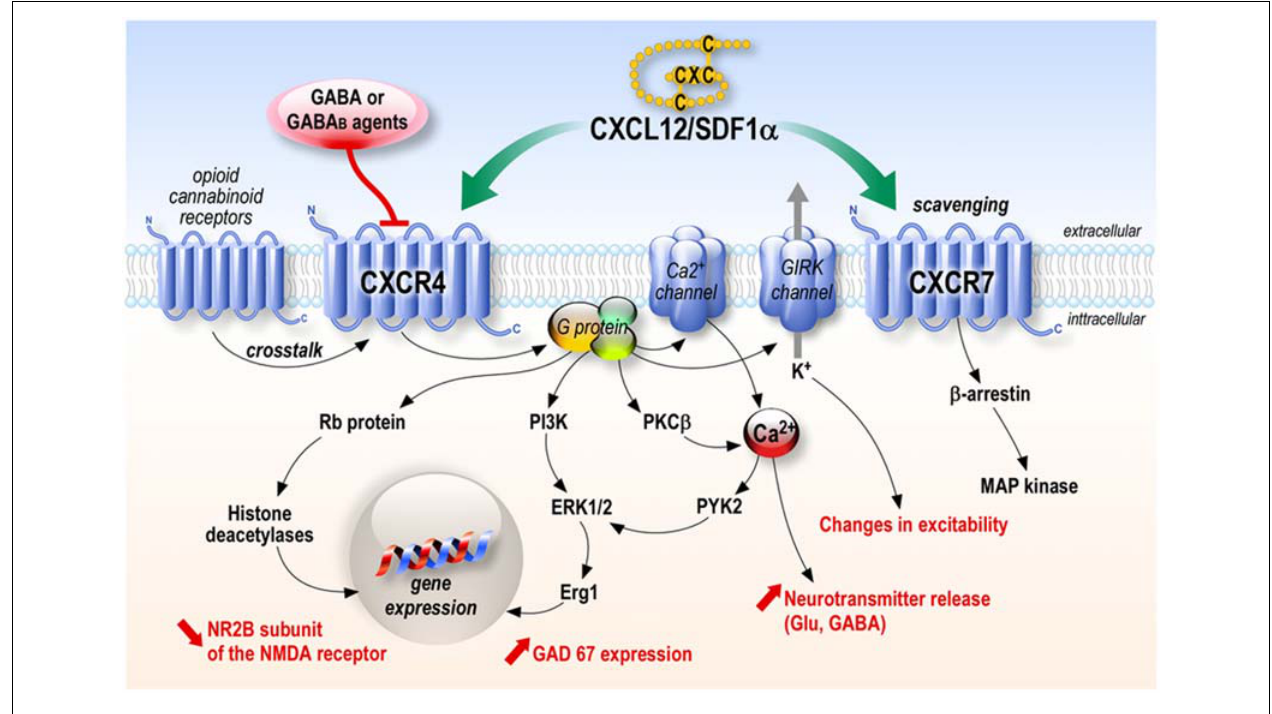
FIGURE 1 | CXCL12 chemokine signaling. CXCL12 acts through its receptors CXCR4 and CXCR7. CXCR4 stimulation leads to the activation of numerous signaling pathways depending on the cell types